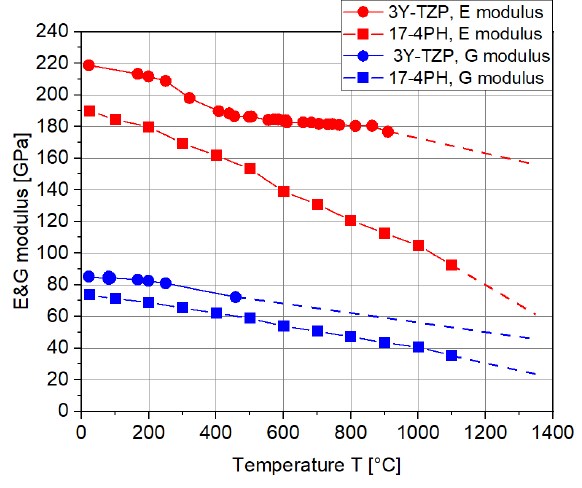
Figure 2. Young’s (E) and shear (G) moduli of 17-4PH and 3Y-TZP at high temperatures.